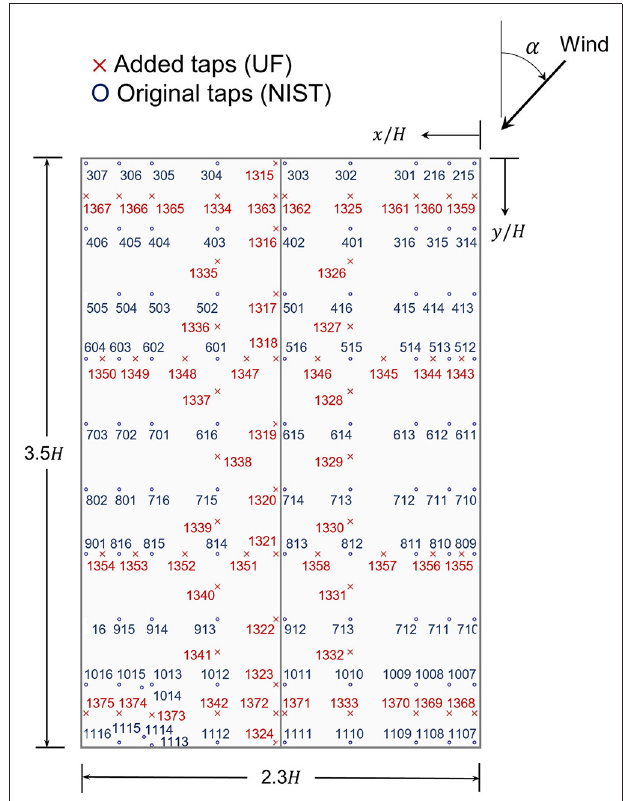
FIGURE 1 | Pressure tap layout on the roof of the three UF WERFL building models. Tap ID and (normalized) coordinates follow the layout of Test 7 (ST3/ST4) of the NIST aerodynamic database. The red “x” markers represent additional taps that were added to the original layout (blue “o”